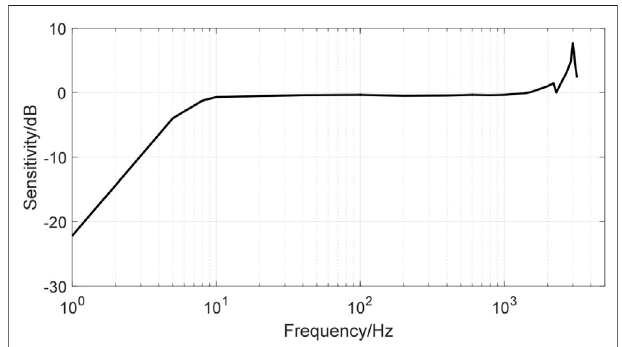
FIGURE 7 | Amplitude-frequency response curve of the seismometer utilized in the metal mine microseismic monitoring network in Xinjiang, China.